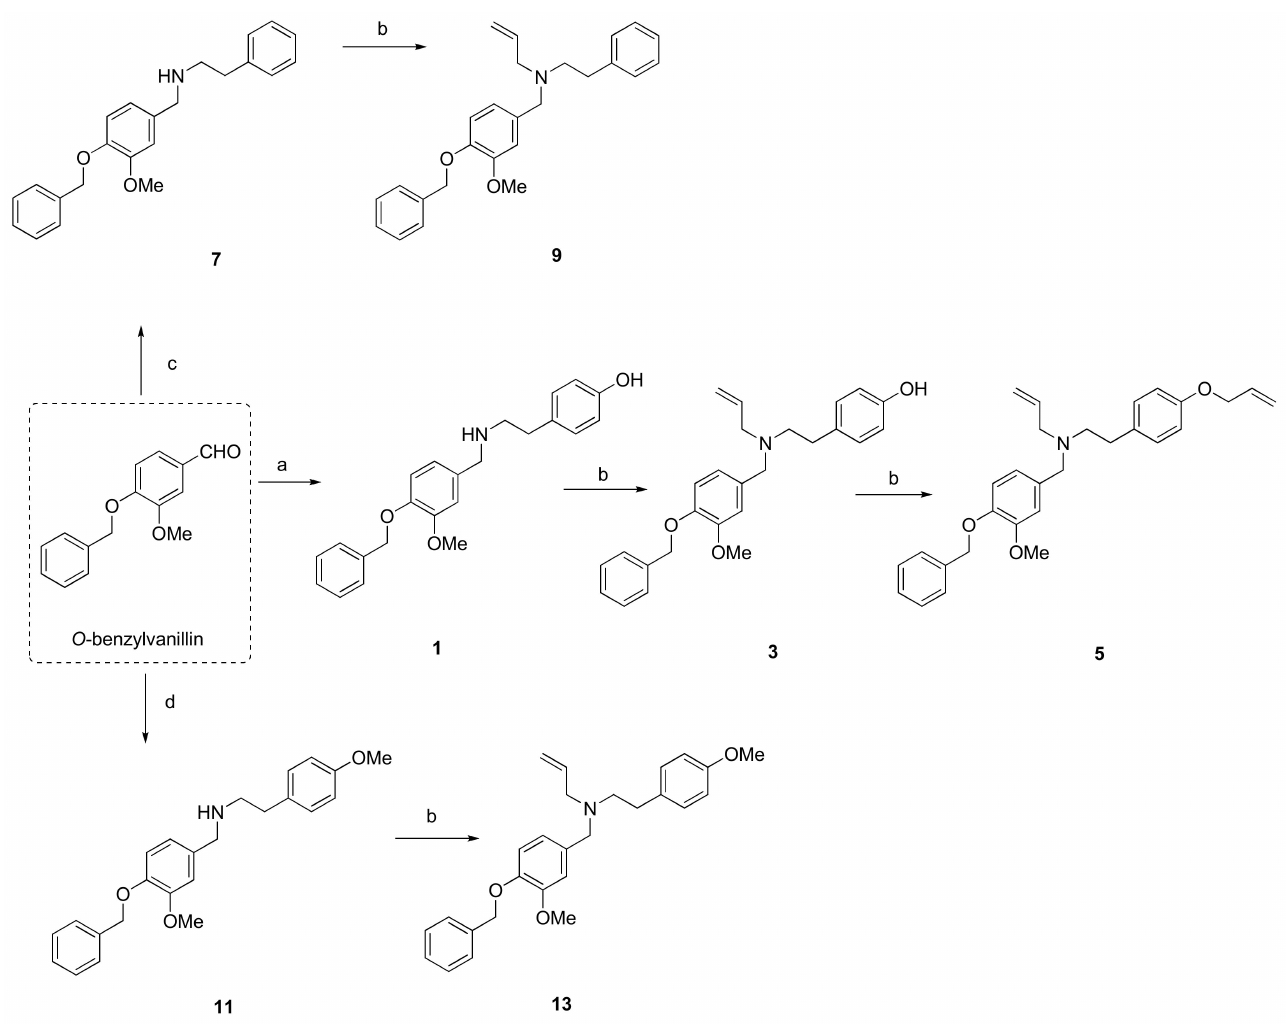
Scheme 1. Synthesis of novel h BuChE inhibitors 1 , 3 , 5 , 7 , 9 , 11 and 13 starting from O -benzylvanillin. Reagents